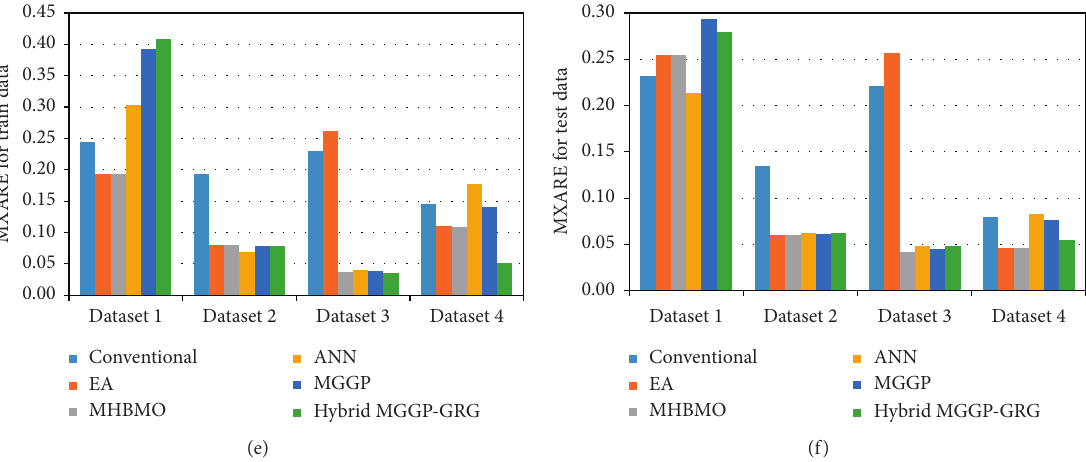
Figure 3: Comparison of the performances of different methods for the data with single-value rating curves based on NE, MARE, and